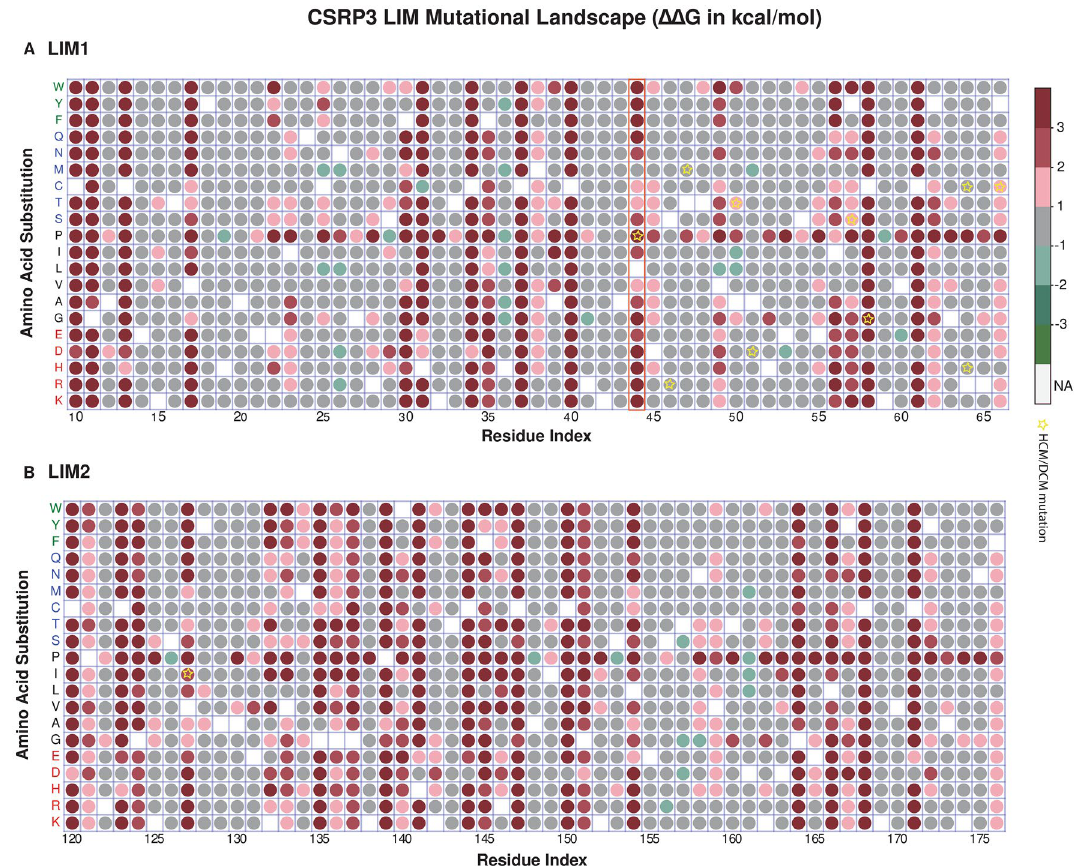
of destabilising (3 ≥ ∆∆G > 2), pink if slightly de-stabilising (2 ≥ ∆∆G > 1), grey when neutral (1 ≥ ∆∆G > − 1), light green when slightly stabilising (− 2 < ∆∆G ≤ − 1), green if stabilising (− 3 < ∆∆G ≤ − 2) and as forest green when highly stabilising (∆∆G ≤ − 3). Original amino acid is kept as blank without any circle. Reported HCM/ DCM mutations are marked with yellow star. ( A ) LIM1 map depicting its mutational flexibility. Leucine 44 substitutions are highlighted in a red color box. ( B ) LIM2 mutational flexibility